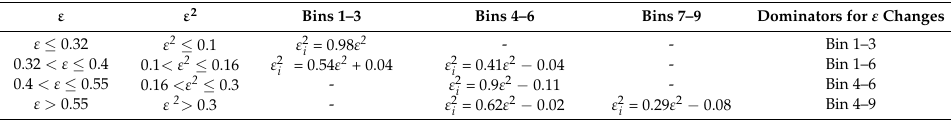
and ε 2 at different ranges of ε 2 i